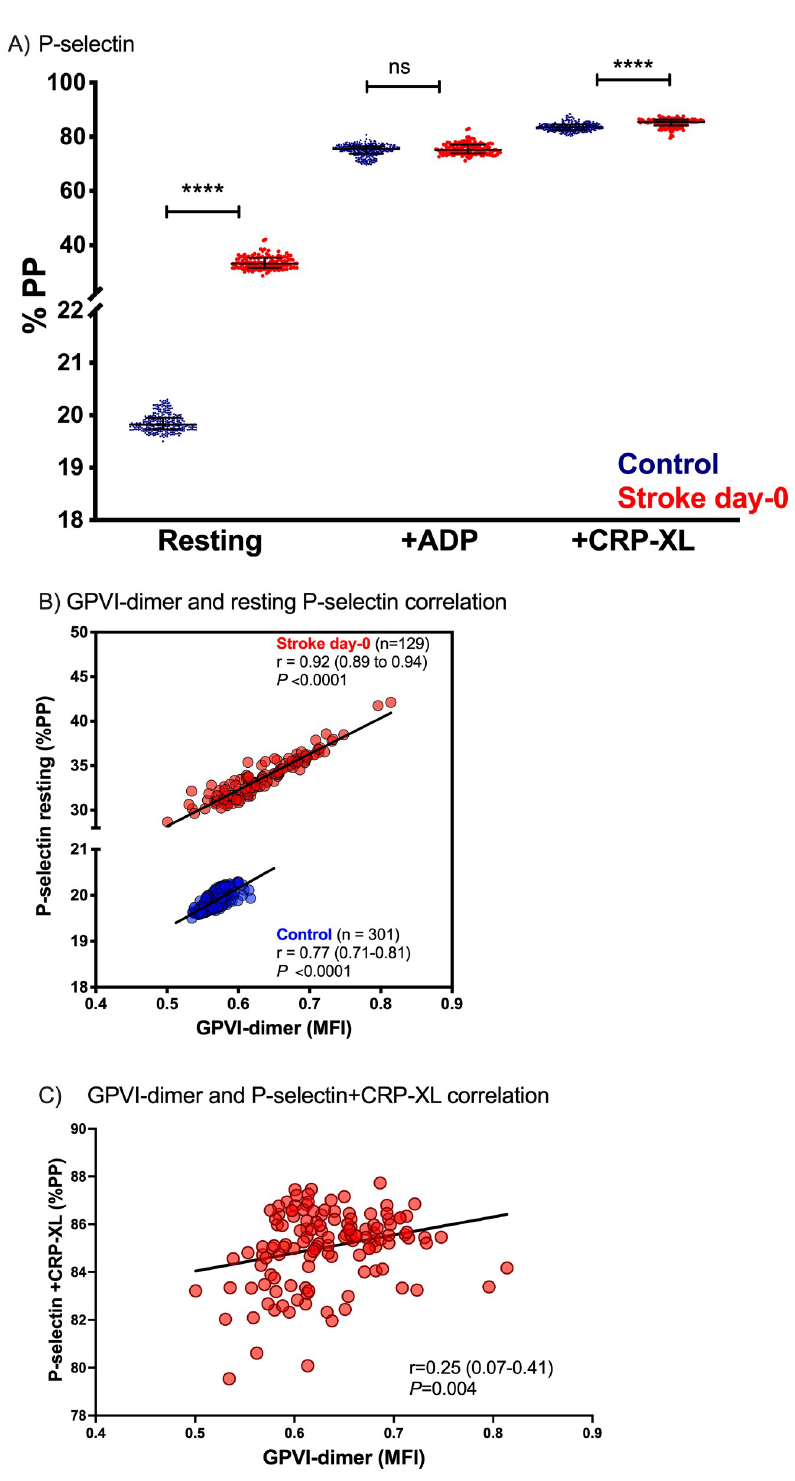
Fig 2. Comparison of P-selectin exposure between control and stroke cohorts and correlation between GPVI- dimer and P-selectin exposure. A) Comparison of P-selectin surface exposure of the stroke patients with the controls show that the stroke patients have more activated “resting” platelets (i.e., before stimulation by exogenous agonist) and after CRP-XL (4 μ g/mL) addition compared to the control group ( P < 0.0001). P-selectin exposure in response to ADP (0.5 μ M) was not significantly different compared to controls. The error bars represent the median (Q1–Q3) %PP of each of the cohorts and P -values were calculated by the Mann-Whitney U-test for non-parametric data. B) GPVI- dimer expression and resting P-selectin exposure in both control and stroke patients are strongly correlated at